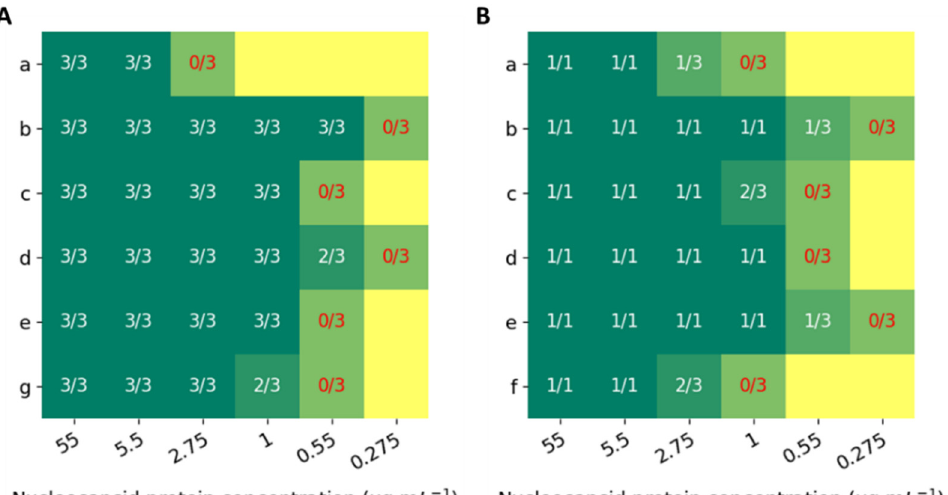
Figure 1. Various RATs were tested to detect a pure nucleocapsid protein in different concentrations, at RH conditions of ( A ) 60% and ( B ) 30%. The RATs are: (a) Deepblue COVID-19 (SARS-CoV-2) Antigen Test Kit (colloidal gold); (b) Easy Diagnosis COVID-19 (SARS-CoV-2) Antigen Test Kit; (c) EcoTest COVID-19 TO-GO; (d) GenSure COVID-19 Antigen Rapid Test Kit; (e) Orient Gene Rapid COVID-19 (Antigen) Self-Test; (f) Panbio COVID-19 Antigen Self-Test; (g) YHLO GLINE-2019-nCoV Ag for self-testing. Within each square are presented a number of positive results out of the replicates’ number.